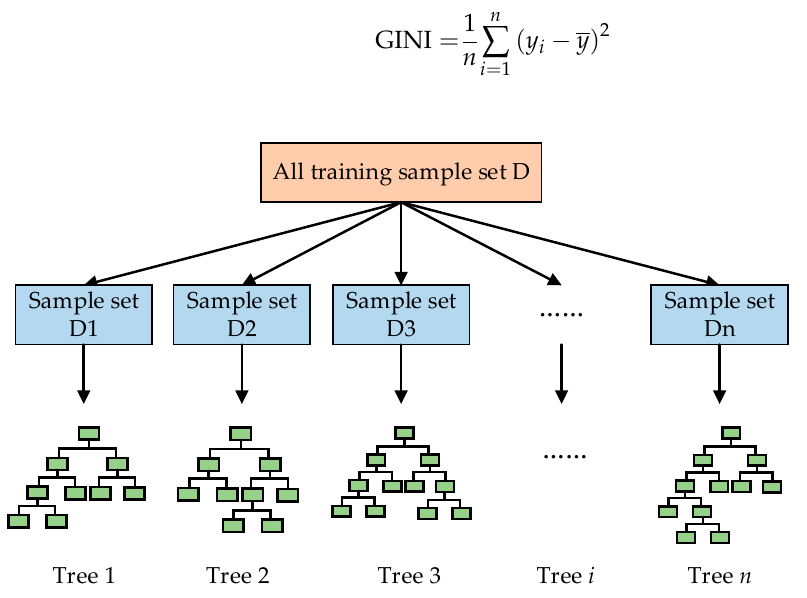
Figure 2. Basic concept of the random forest algorithm.